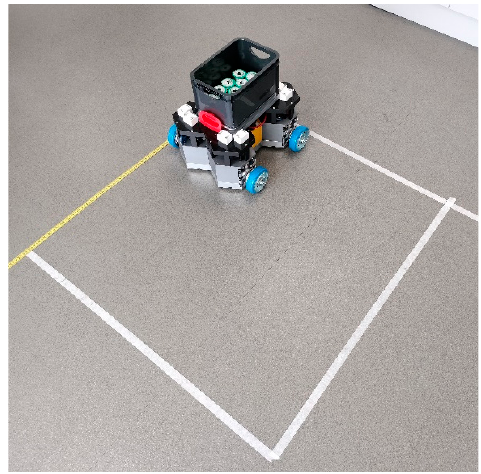
Figure 33. Physical path and real mobile robot.